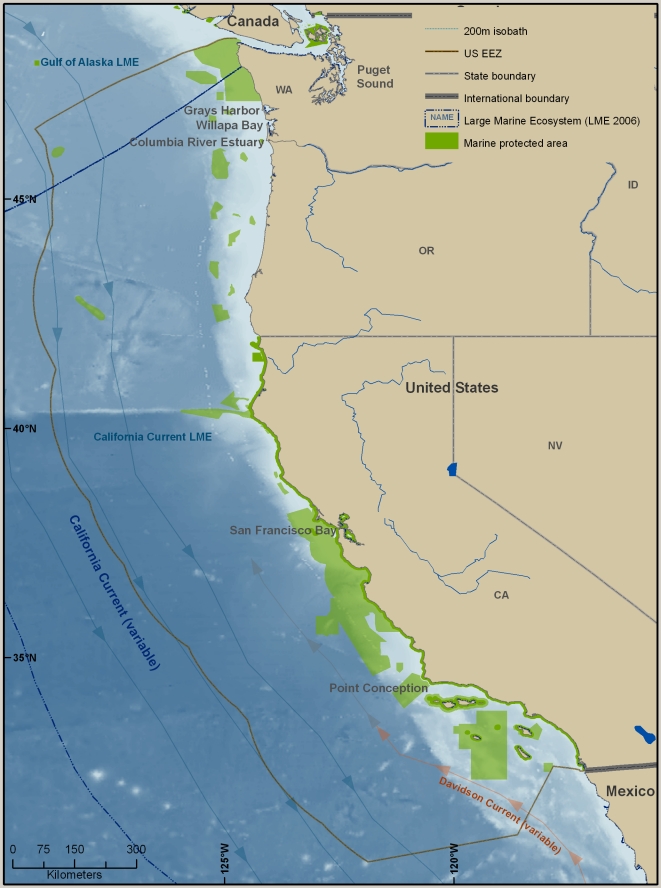
California Current Large Marine Ecosystem (CCLME).Map also shows EEZ boundaries, state boundaries, international boundaries, marine ecoregions, marine protected areas, major embayments, bathymetry and major oceanic currents.